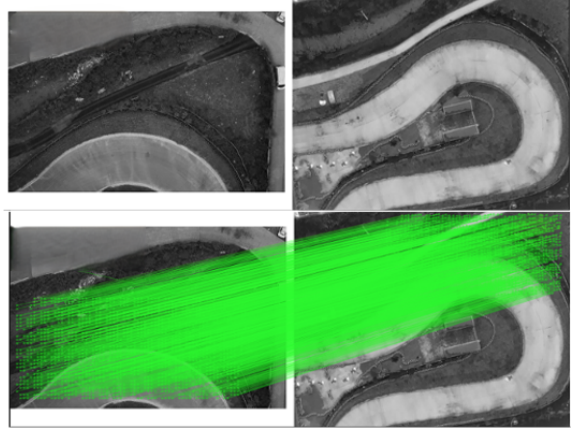
Figure 11. Here is a non-bridge and thermal image pair from different viewpoints: the top is the original image, and the bottom is the result of visualizing our generated supervision.